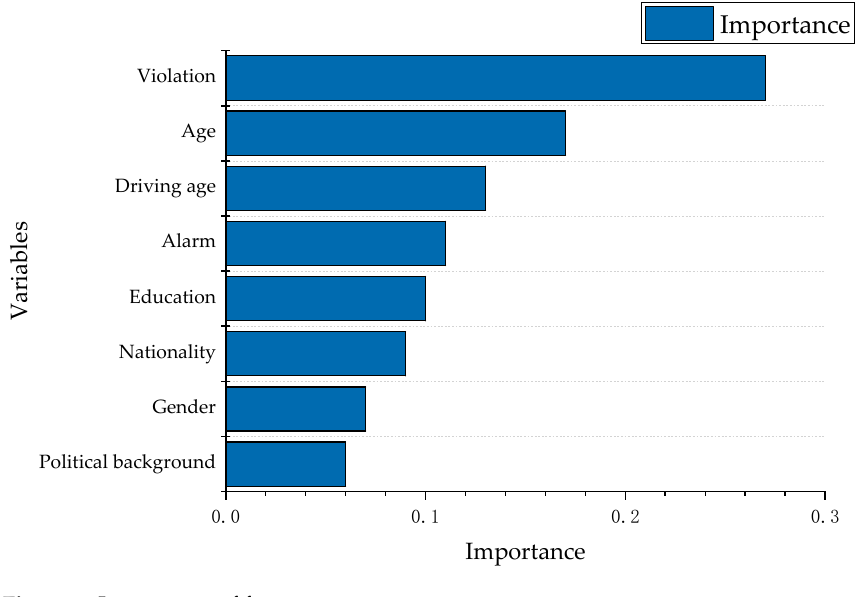
Figure 2. Importance of factors.